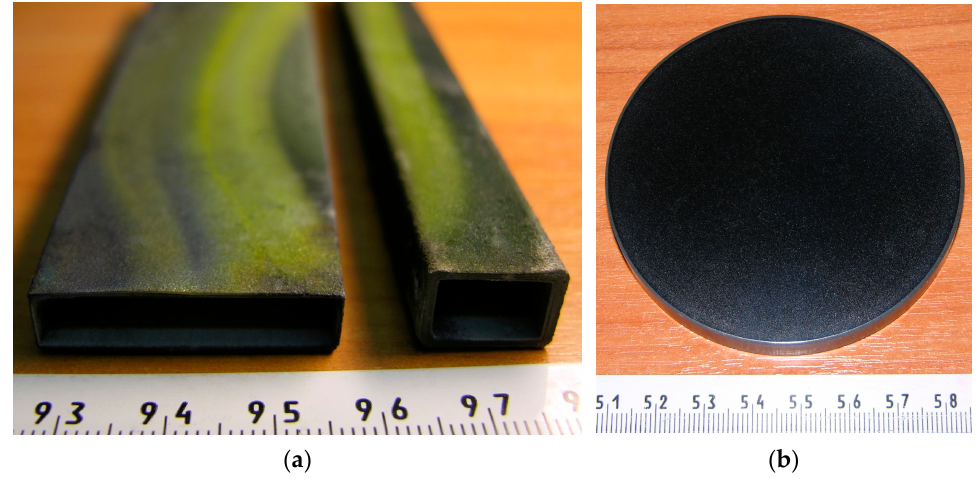
Figure 8. SiC rectangular tubes with a wall thickness of 1–1.5 mm ( a ) and a SiC magnetron sputtering target of 70 mm in diameter and 6 mm in thickness ( b ), which were obtained by deposition onto removable graphite substrates.